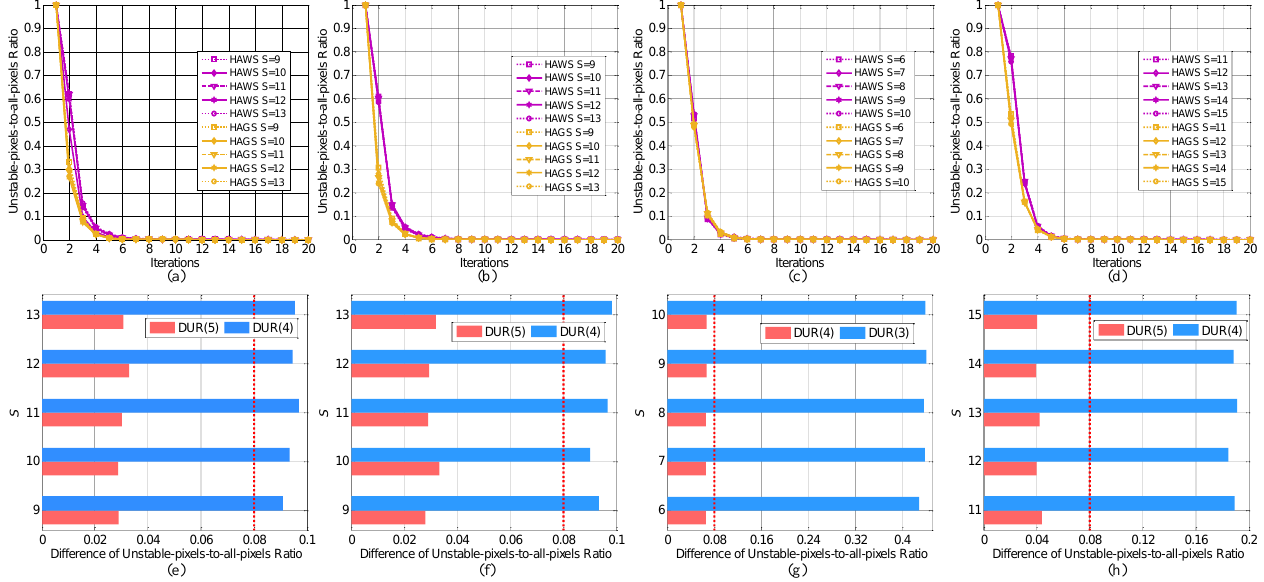
Figure 10. Results of UR and DUR based on HAWS and HAGS. ( a , e ) and ( b , f ) are the results of 400 × 400 and 500 × 500 simulated data sets. ( c , g ) are the results of AIRSAR data set. ( d , h ) are the results of RADARSAT-2 data